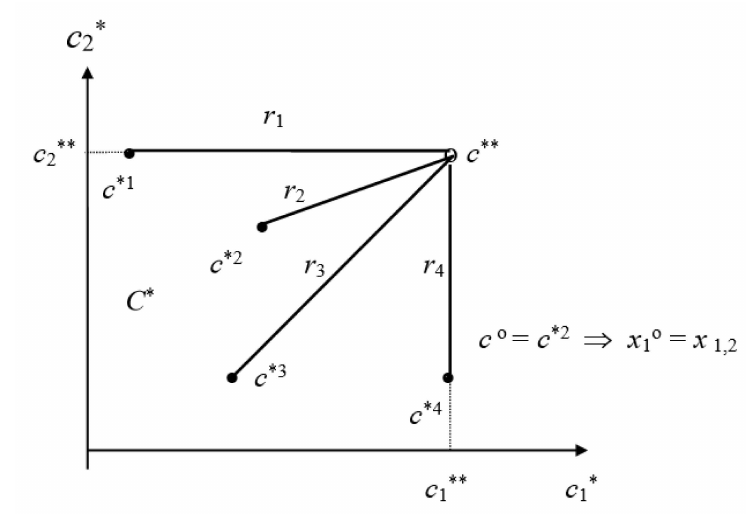
Figure 3. Graphical interpretation of the solution to the optimization task